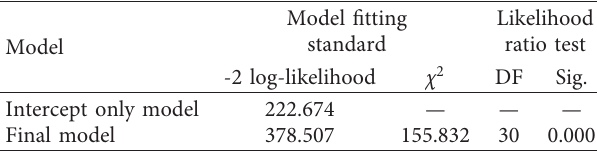
Table 6: Significance test of regression coefficient.